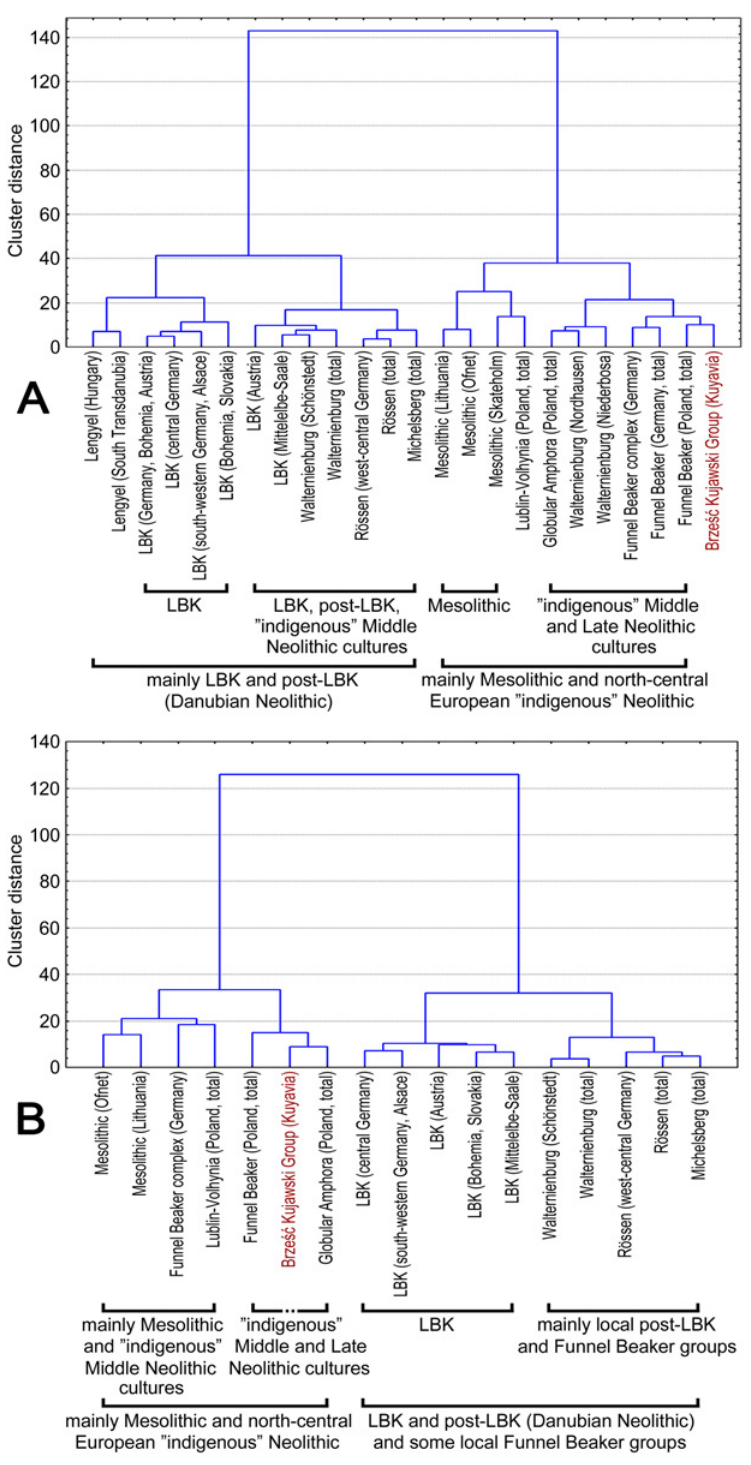
Fig 4. Affinities between the Mesolithic and Neolithic populations from central Europe based on craniometric data: male (A) and female (B) series.